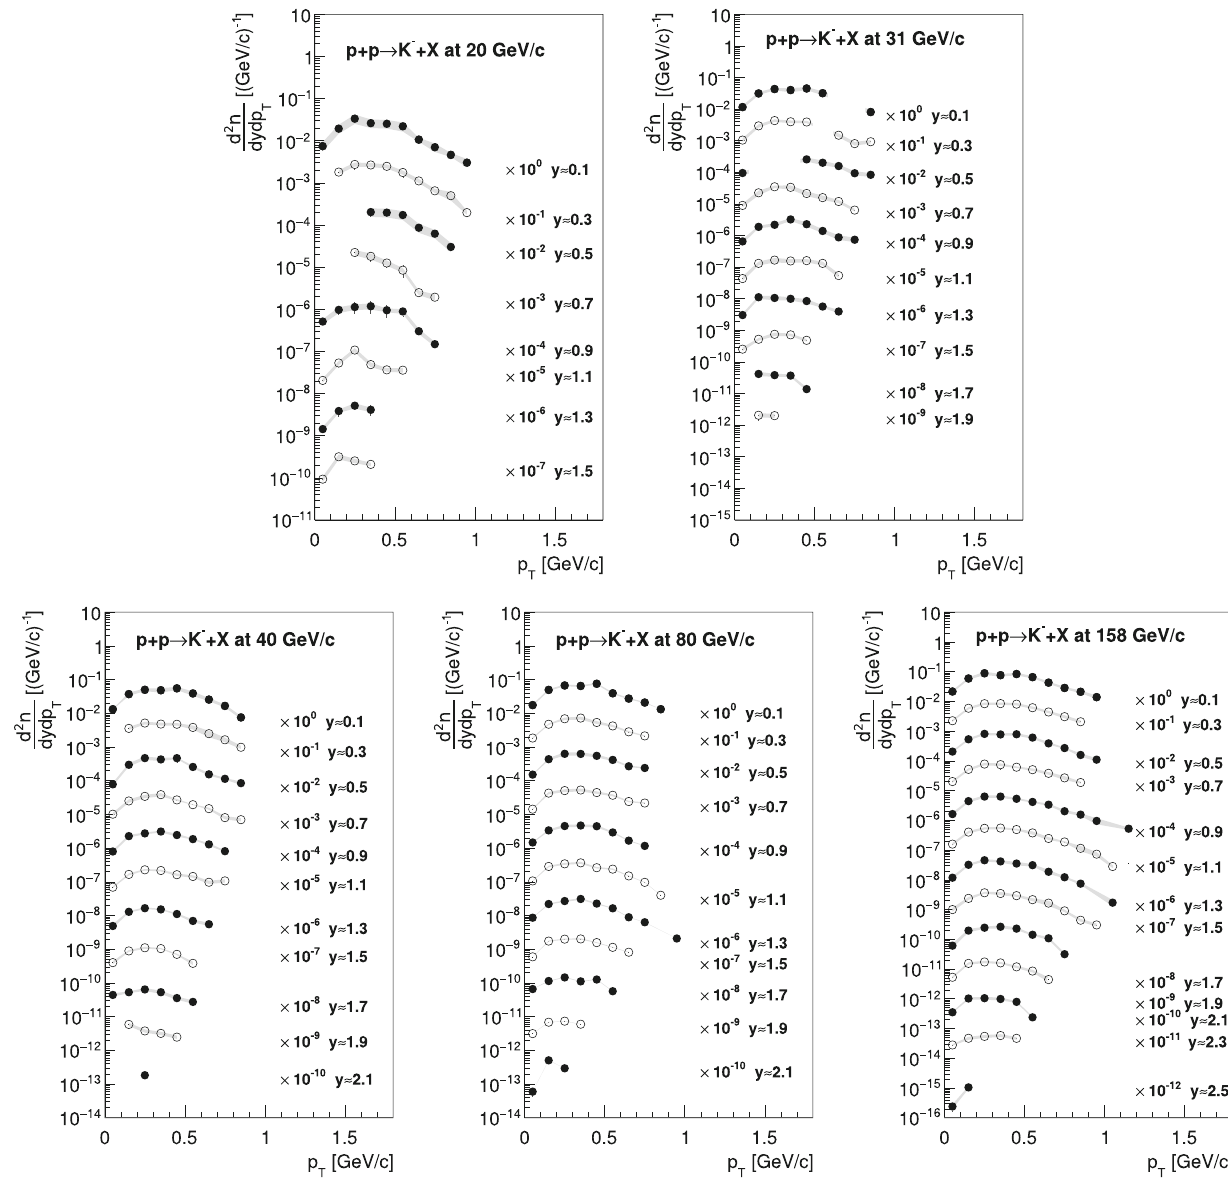
Fig. 26 Transverse momentum K − spectra in rapidity slices produced in inelastic p + p interactions at 20, 31, 40, 80, 158 GeV / c . Rapidity values given in the legends correspond to the middle of the corresponding interval. Shaded bands show systematic